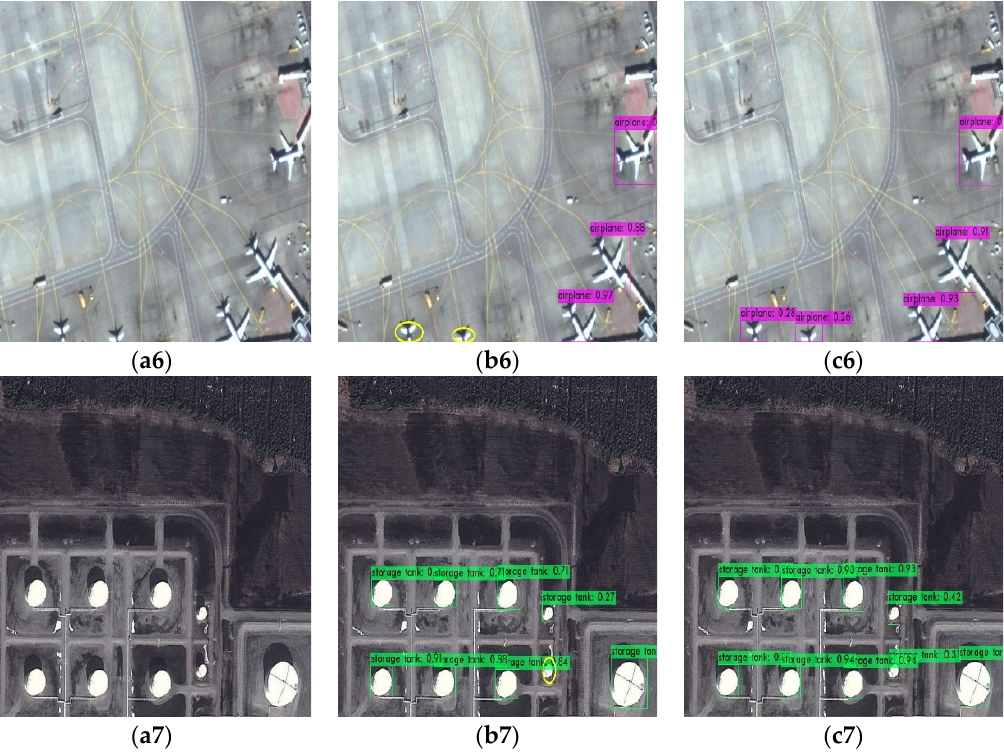
Figure 11. Comparison of the detection effect of our method and YOLO v4. ( a1 – a7 ) is the original image, ( b1 – b7 ) is the YOLO v4 detection result, ( c1 – c7 ) is the detection result of this algorithm.